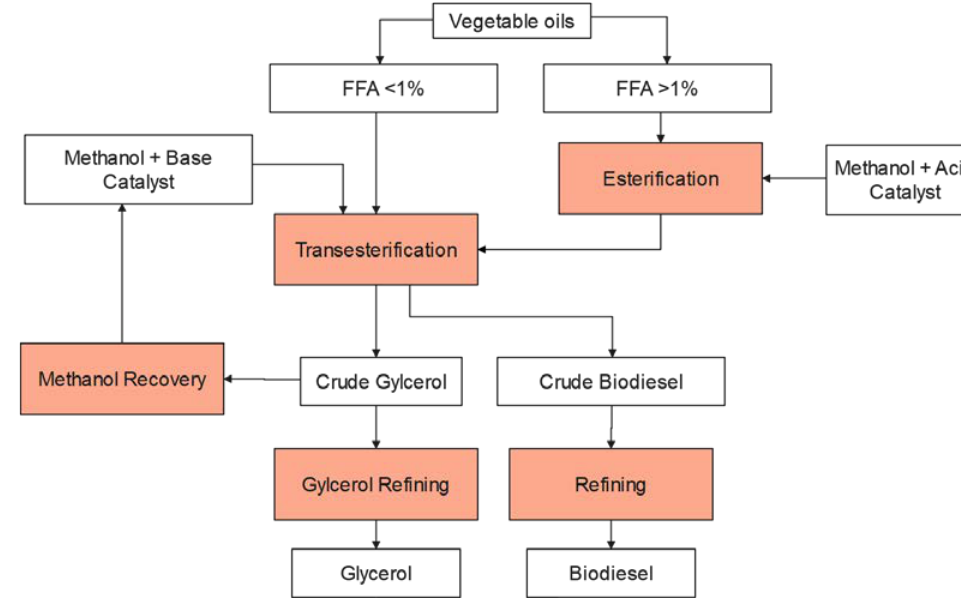
Figure 2. General biodiesel production process.